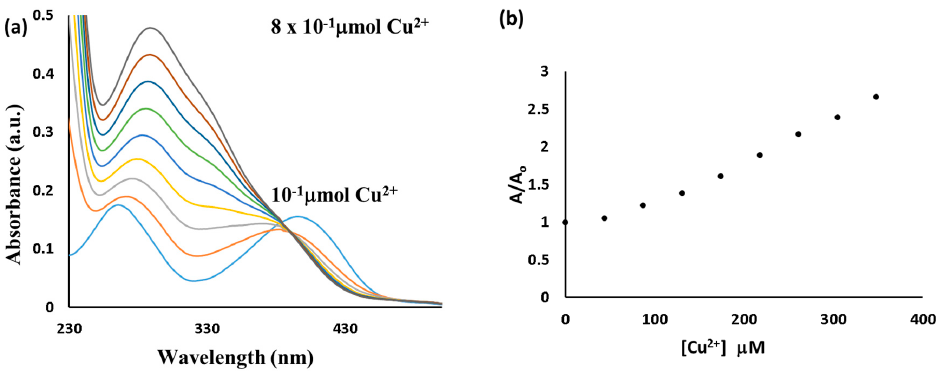
Figure 3. ( a ) Changes in the absorption spectrum of P1 (4 × 10 − 3 g/L) in acetonitrile upon the addition of Cu 2+ aliquots (0.05 M); ( b ) Plots of A/A o against [Cu 2+ ].